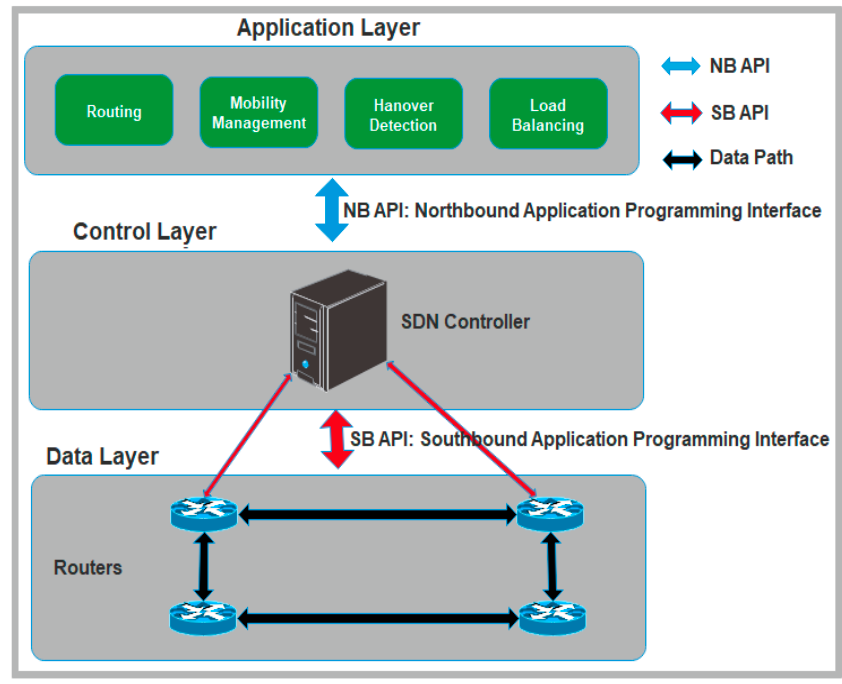
Figure 3. Software-defined networks model [20].